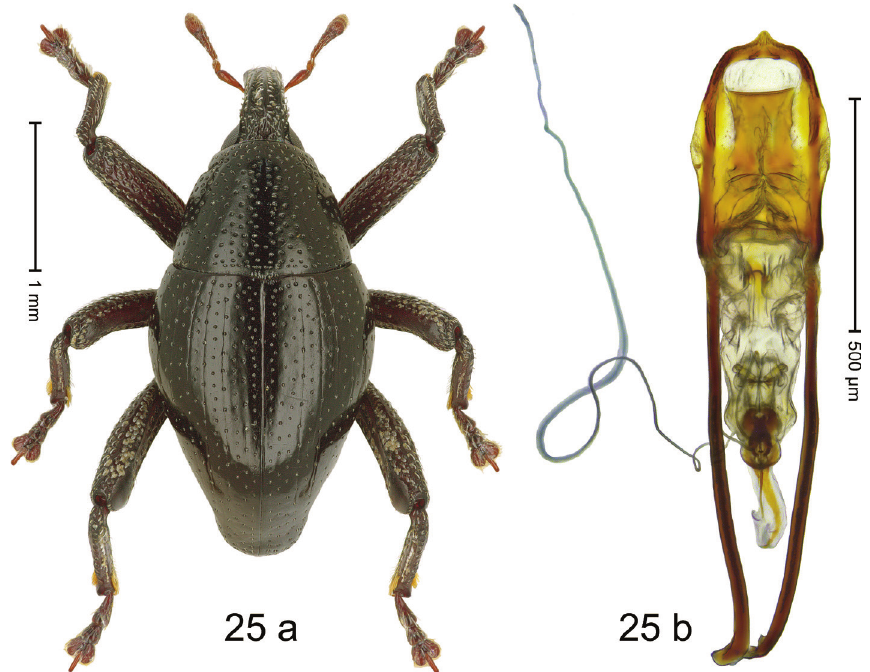
Figure 25. Trigonopterus toboliensis sp. nov., holotype a habitus b